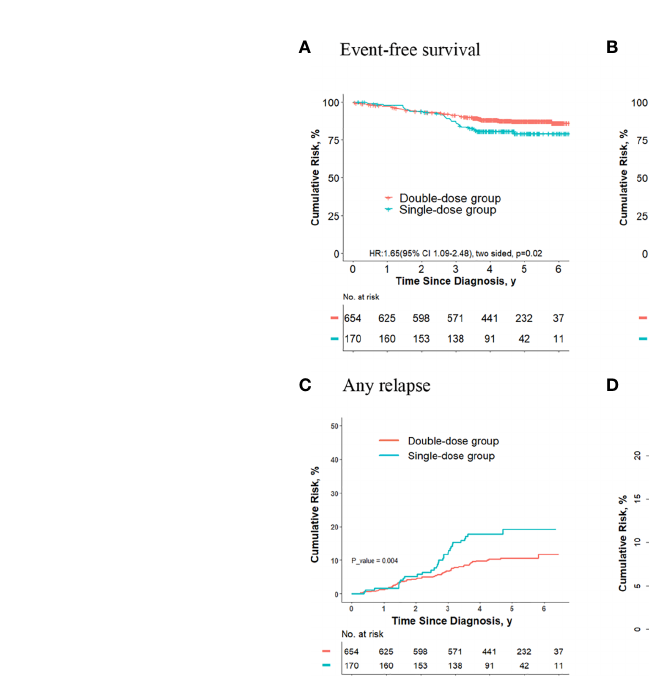
FIGURE 6 | Analysis of survival and cumulative risk of relapse and early death for fi nal low-risk patients without ETV6-RUNX1 positivity or hyperdiploidy ALL.